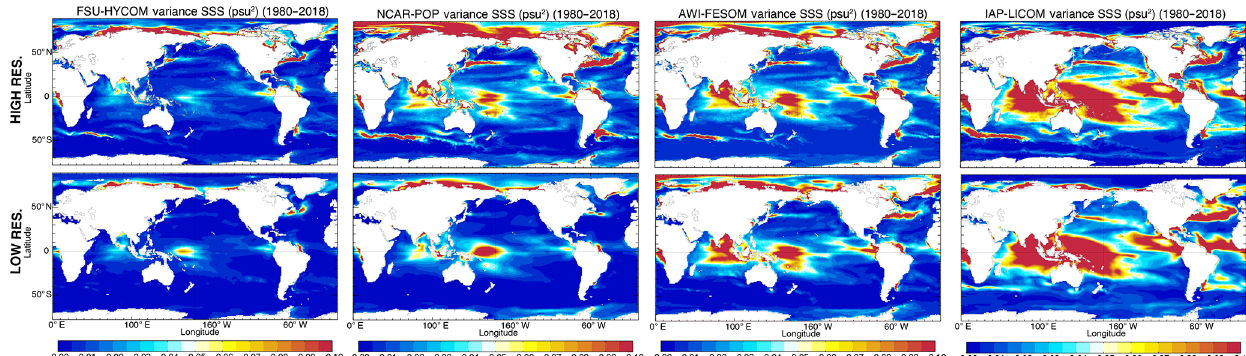
Figure 23. Modeled and observed deseasonalized SSS